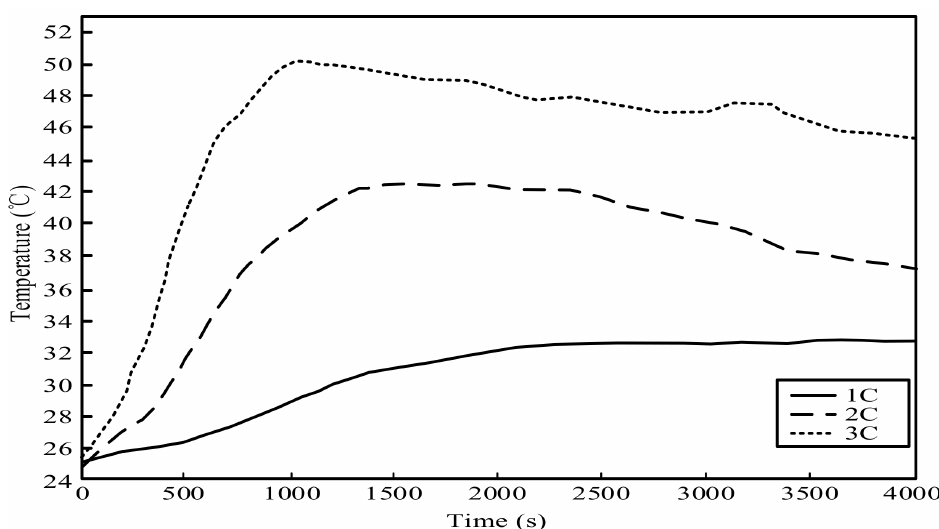
Figure 5. Temperature variation of heat-generation model under different